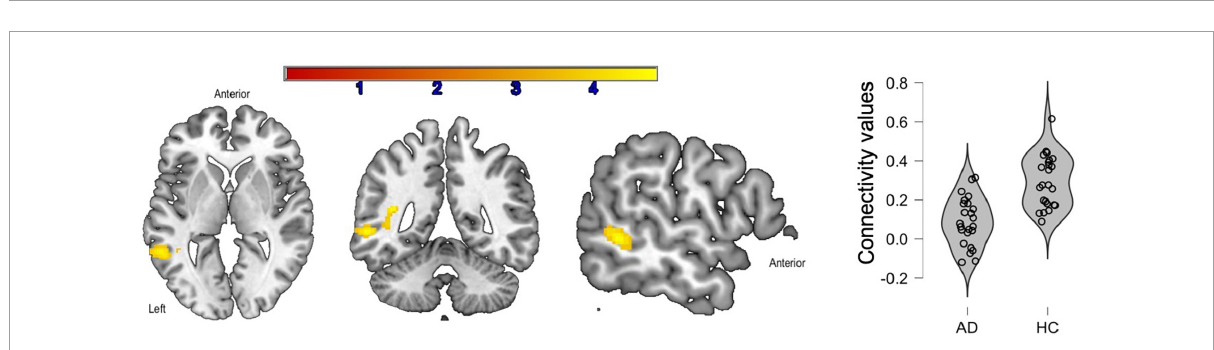
FIGURE3 Significant clusters (in yellow) after inter-group comparisons [healthy older adults (HC) vs. prodromal Alzheimer’s disease (AD)]. The violin plots show connectivity values for each participant in each